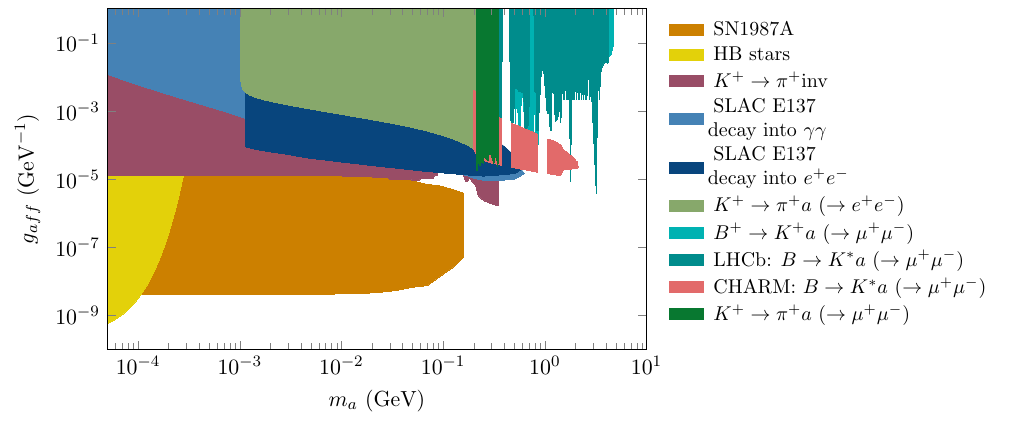
Figure 3 . Full constraint plot on the ALP-fermion coupling g aff as a function of the ALP mass m a for an ALP which only couples to SM fermions at tree level. We show collider and astrophysical constraints discussed in section